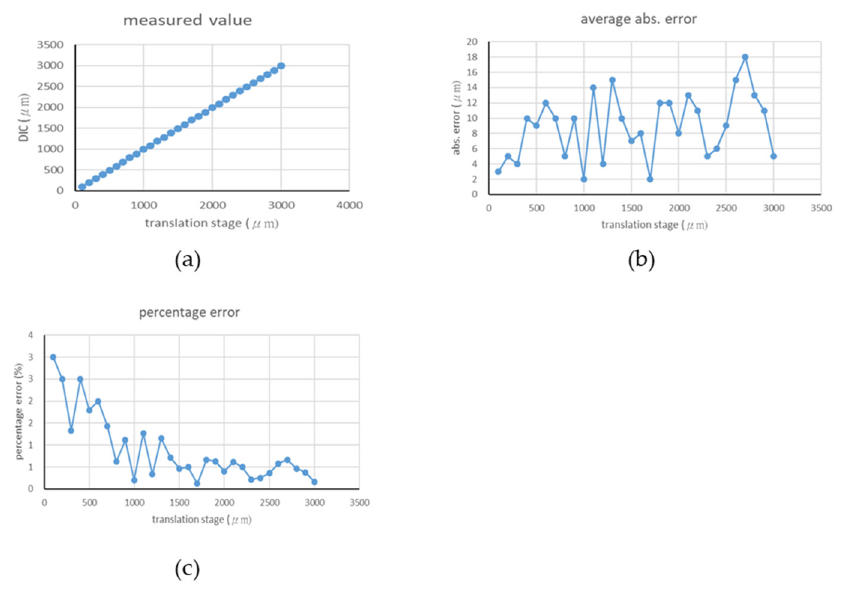
Figure 11. Image of bio-tissue rigid body translation experiment.